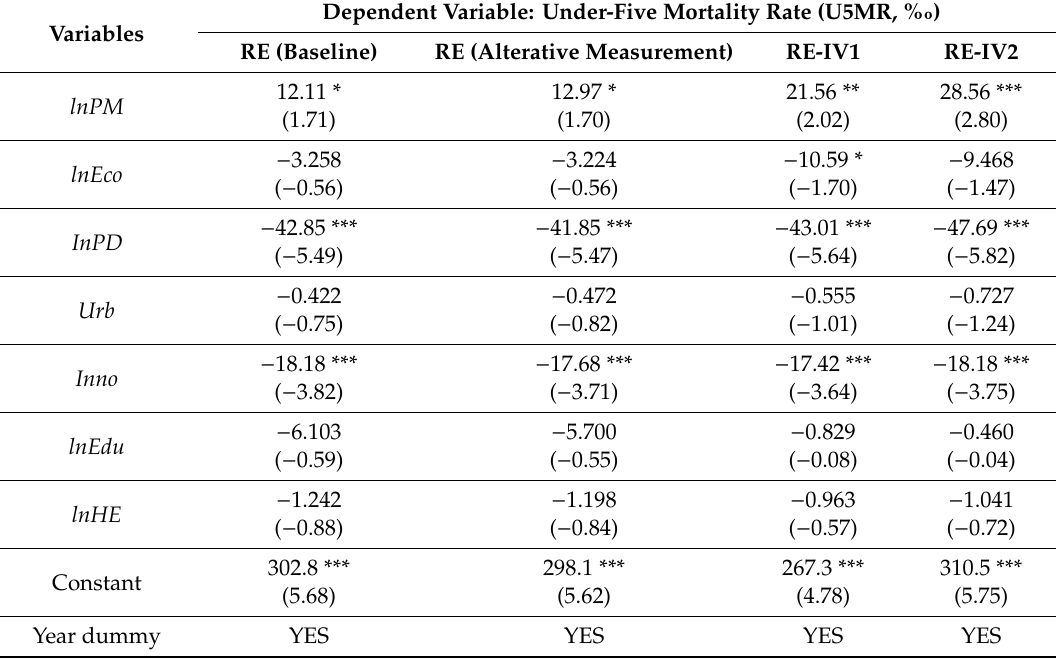
Table 8. Estimation result of least developed